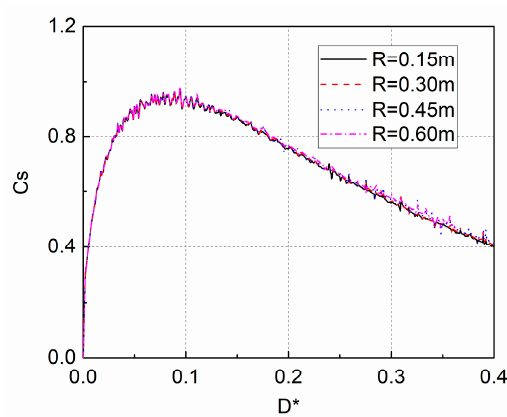
Figure 14. Variations of the non-dimensional impact force with different radii.